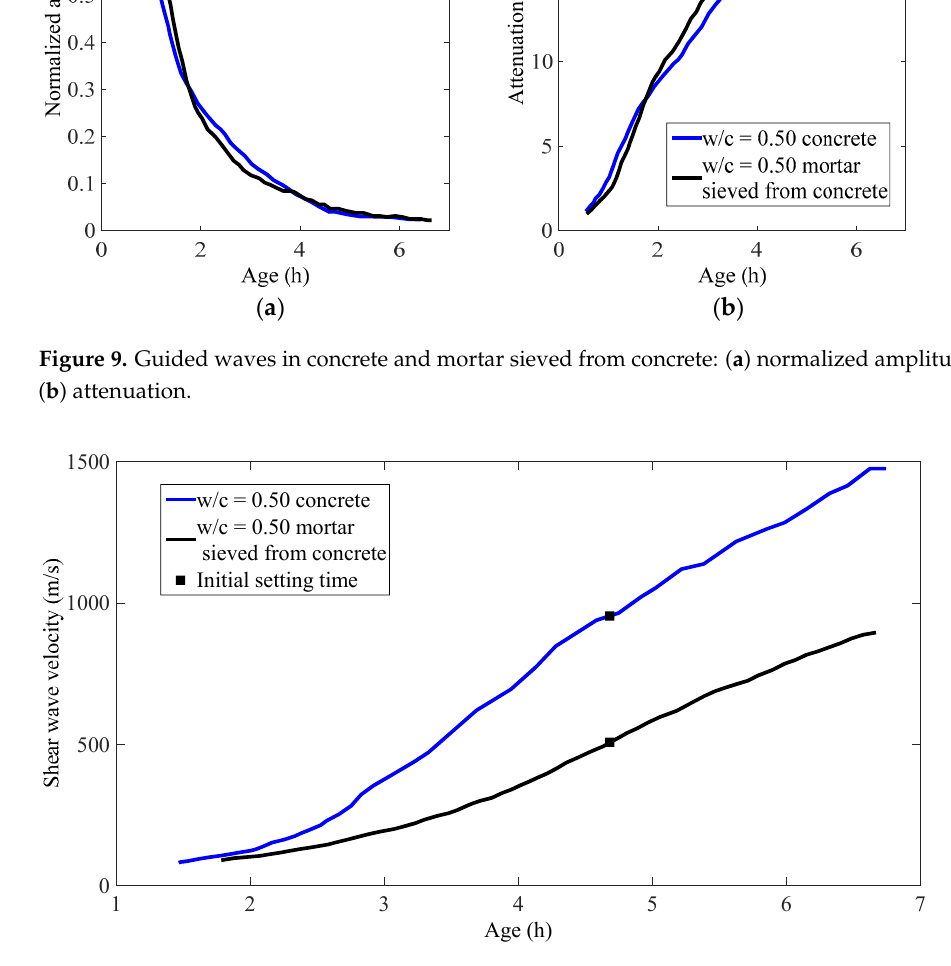
Figure 9. Guided waves in concrete and mortar sieved from concrete: ( a ) normalized amplitude and ( b ) attenuation.